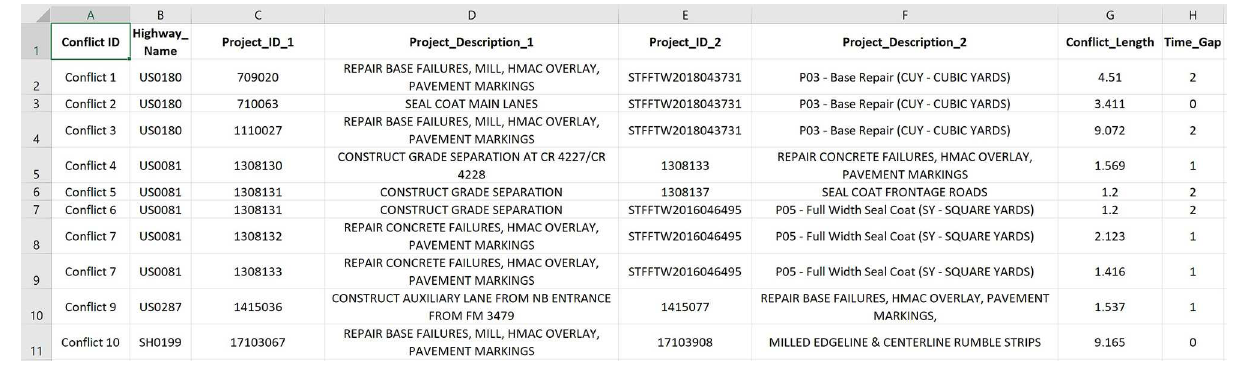
FIGURE 7 | Detailed information on conflicts in Conflicts Coordination